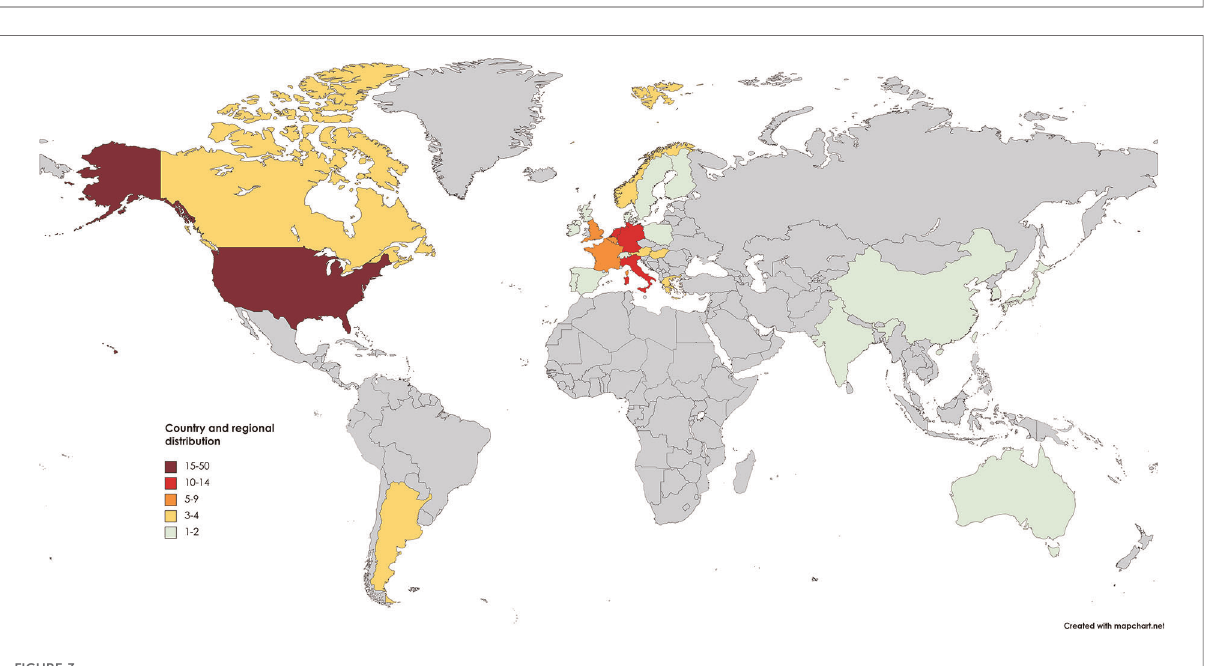
FIGURE 3 World map for the geographical distribution of the T100